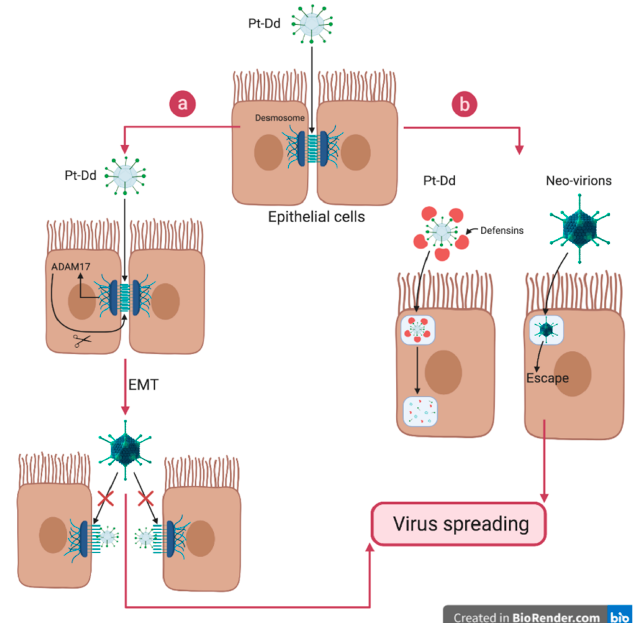
Figure 5. Biological function of the dodecahedron ‘pseudovirus’. Pt-Dd facilitates virus spreading by both interacting with DSG2 and acting as a decoy. ( a ) Pt-Dd binds to the virus receptor desmoglein 2 located in desmosomes and induces an epithelial to mesenchymal transition (EMT) through MAP kinase signaling and activation of the ADAM17 matrix-metalloproteinase. Moreover, competition between Pt-Dd and virions for DSG2 forces virions to spread in the tissue. ( b ) At the same time, Pt-Dd traps Human Defensin (HD)5, which is known to block adenovirus infection by stabilizing the capsid, thus preventing pVI release and subsequent endosomolysis. By acting as a decoy, Pt-Dd protects neo-virions from defensin attack. Figure created with